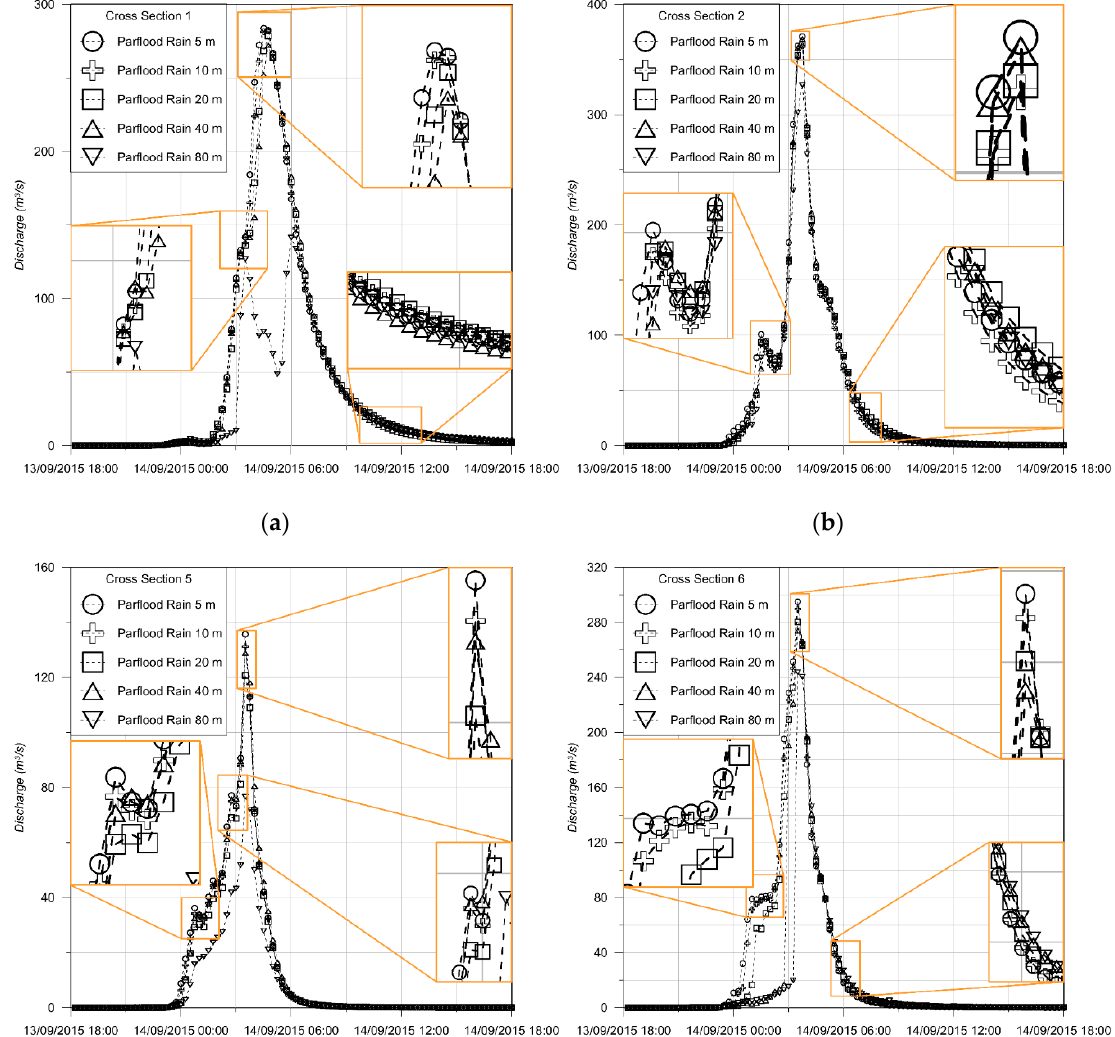
Figure 14. Discharge hydrographs for uniform grid resolutions (5, 10, 20, 40 and 80 m) at: ( a ) Cross Section 1; ( b ) Cross Section 2, ( c ) Cross Section 5 and ( d ) Cross Section 6.